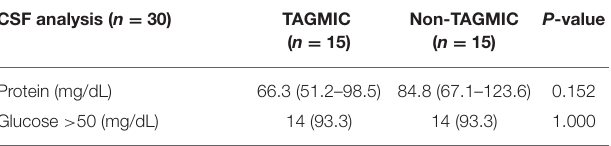
TABLE 1 | Comparison of baseline data between the TAGMIC and non-TAGMIC